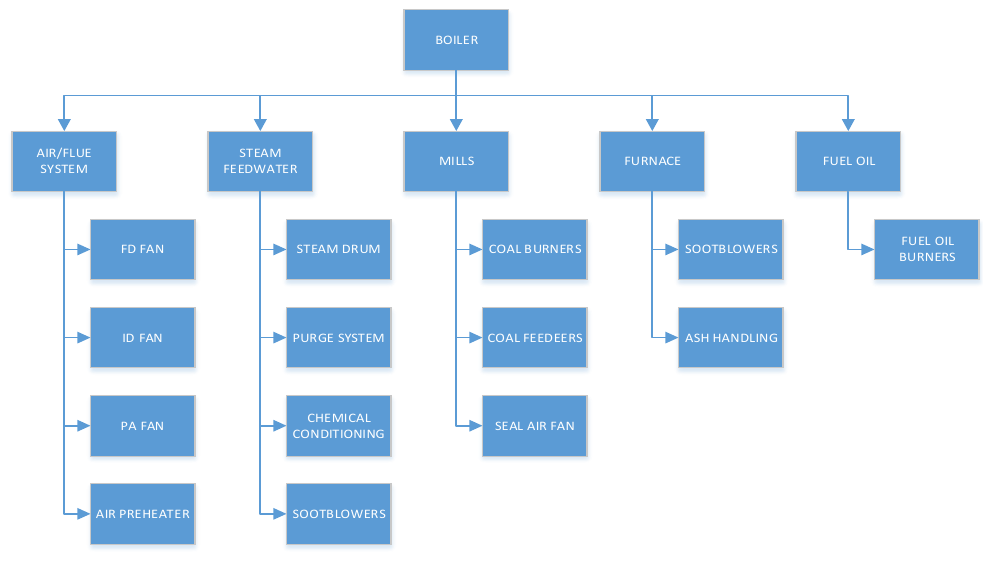
Figure 7. Boiler functional tree.